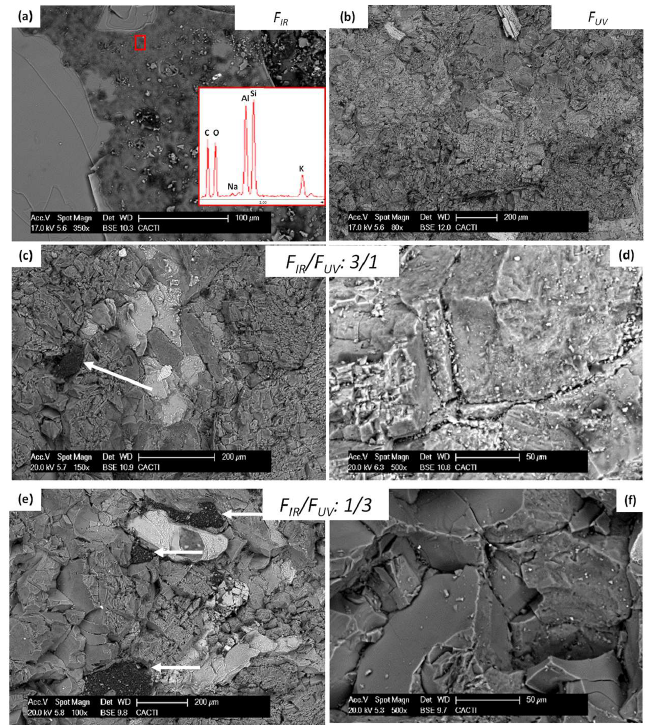
Figure 7. SEM micrographs of the areas treated with the selected conditions to extract black graffiti using 1064 nm (IR) ( a ); 355 nm (UV) ( b ) and their simultaneous use: ( c , d ) F IR / F UV ratio 3/1 and ( e , f ) F IR / F UV ratio 1/3. Graffiti remains are pointed out with arrows. Detailed information on fluence values and pulses for each irradiation condition can be found in Table 2.